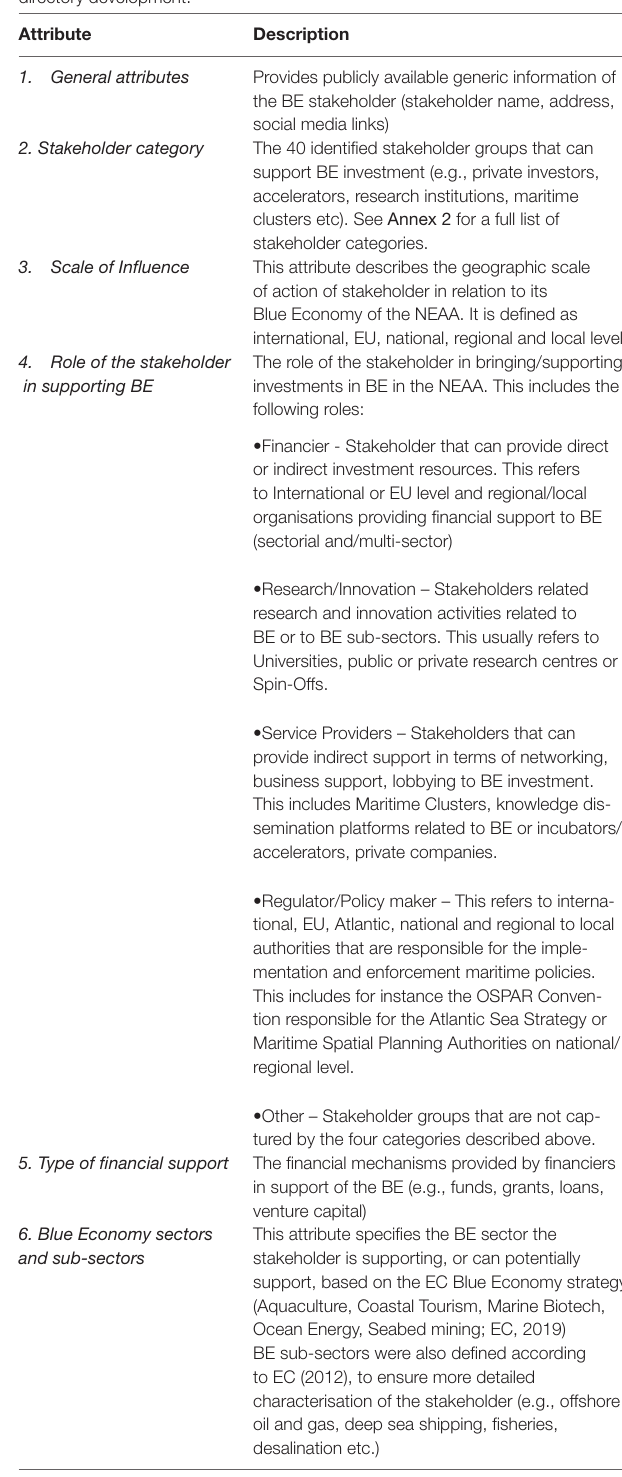
TABLE 2 | Overview and description of the attributes defined for the stakeholder directory